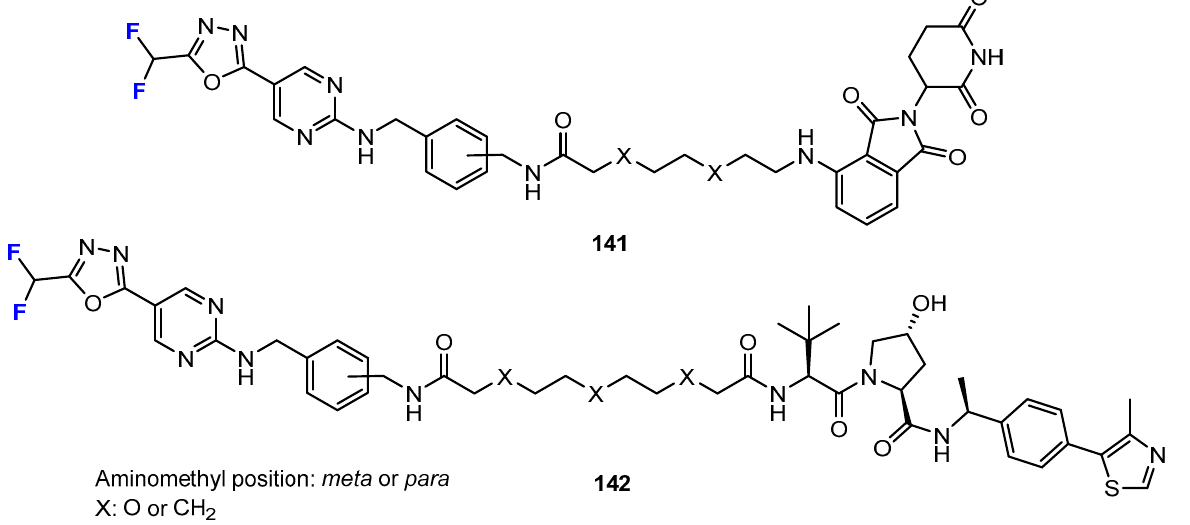
Figure 11. Chemical structures of fluorinated HDAC6-addressing PROTACs by Keuler, König, Bückreiß et al. [85].